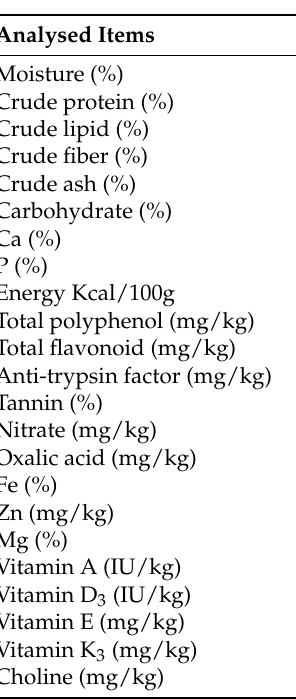
Table 2. The chemical compositions of seaweed ( H. palmata